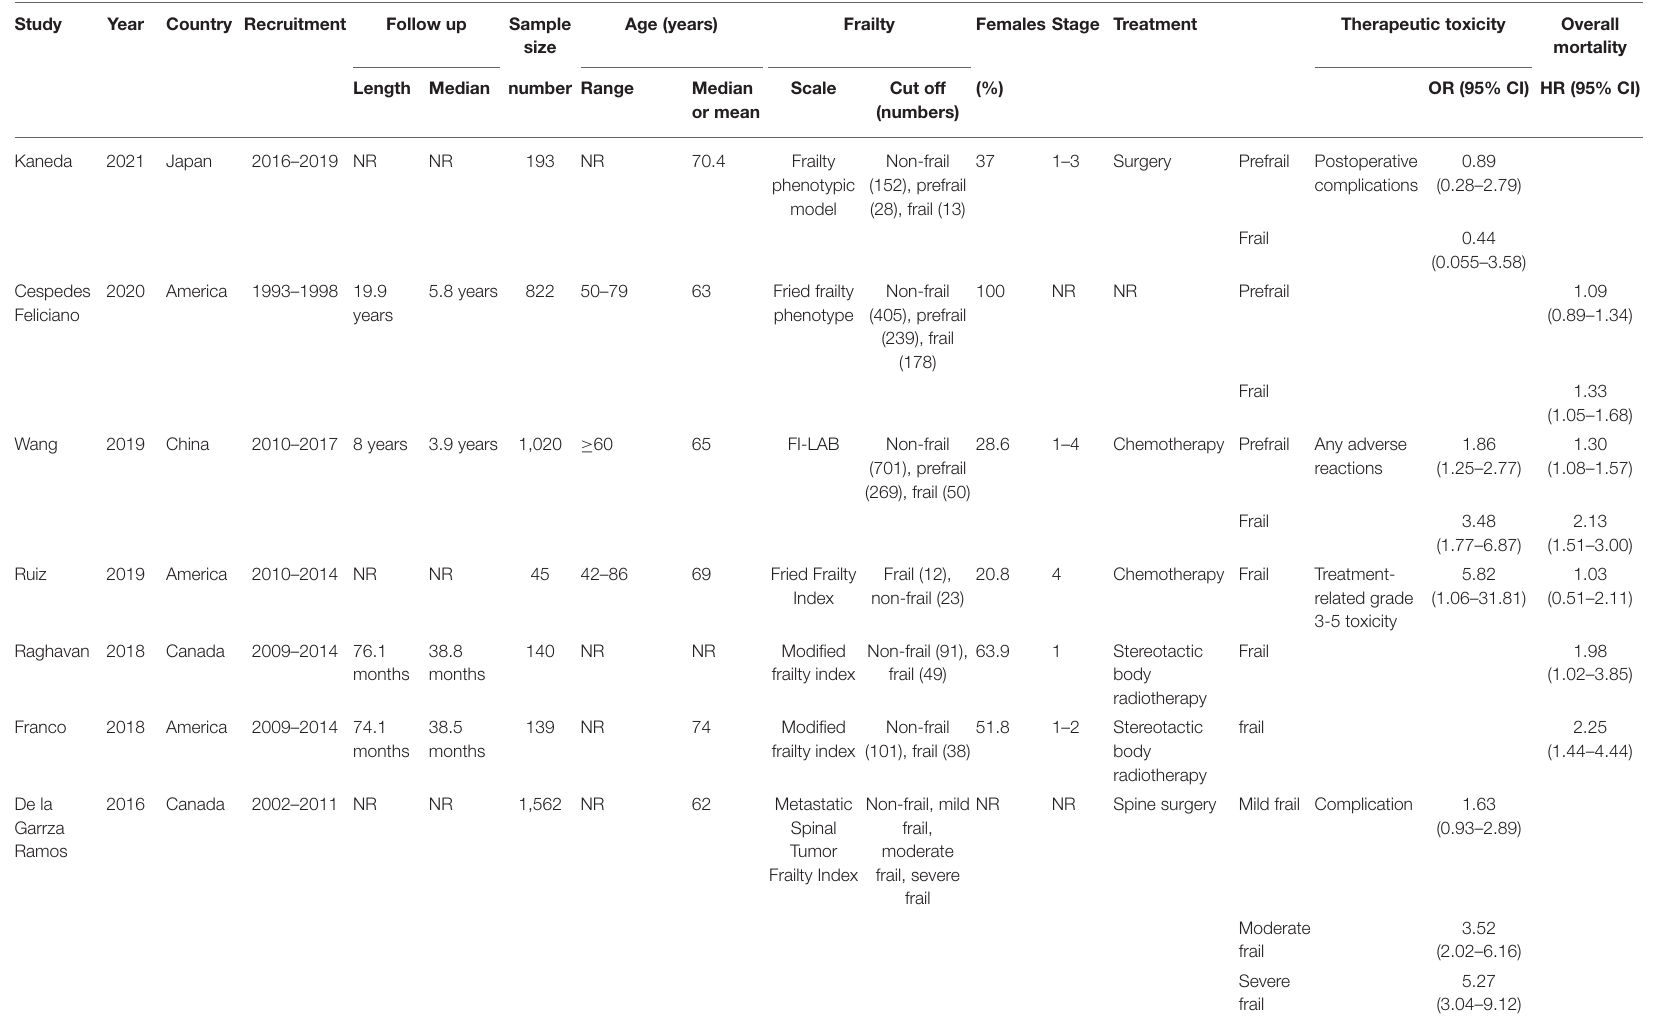
TABLE 1 | Baseline characteristics of the included